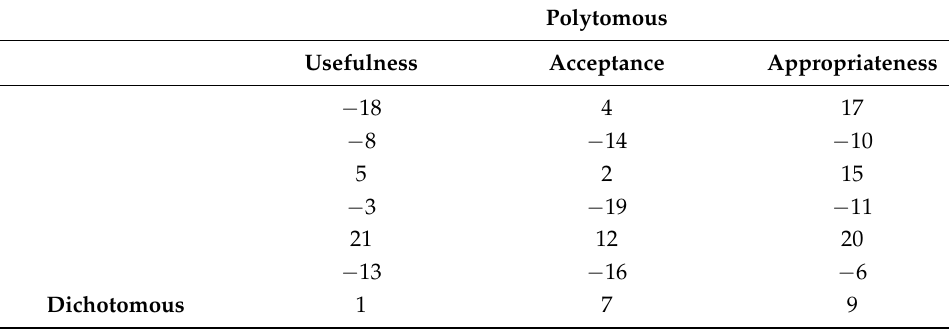
Table 2. Required reordering of questions before running the